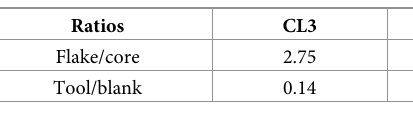
niques from CL3 to CL1a. For example, the frequency of abrasion and battering on the exterior platform surface increased from CL3 to CL2 before declining sharply in CL1b and CL1a. The